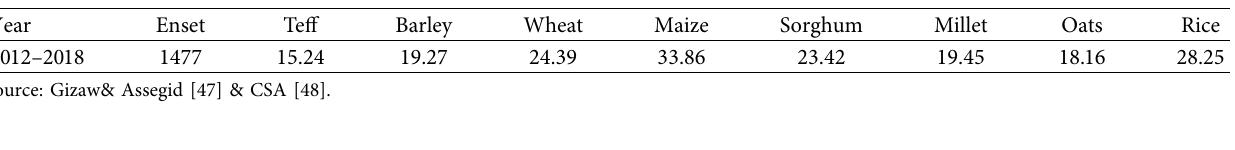
Table 2: Comparison of the nutritive value of the food nexus with wheat, maize, rice, and teff. Food & its